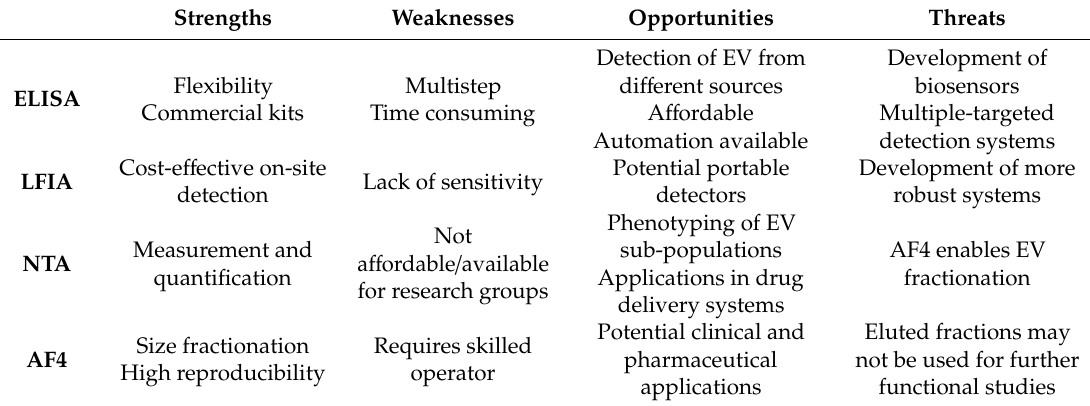
Table 1. Summary of the SWOT (Strengths–Weaknesses–Opportunities–Threats) Analysis of Di ff erent Techniques for EV Detection and